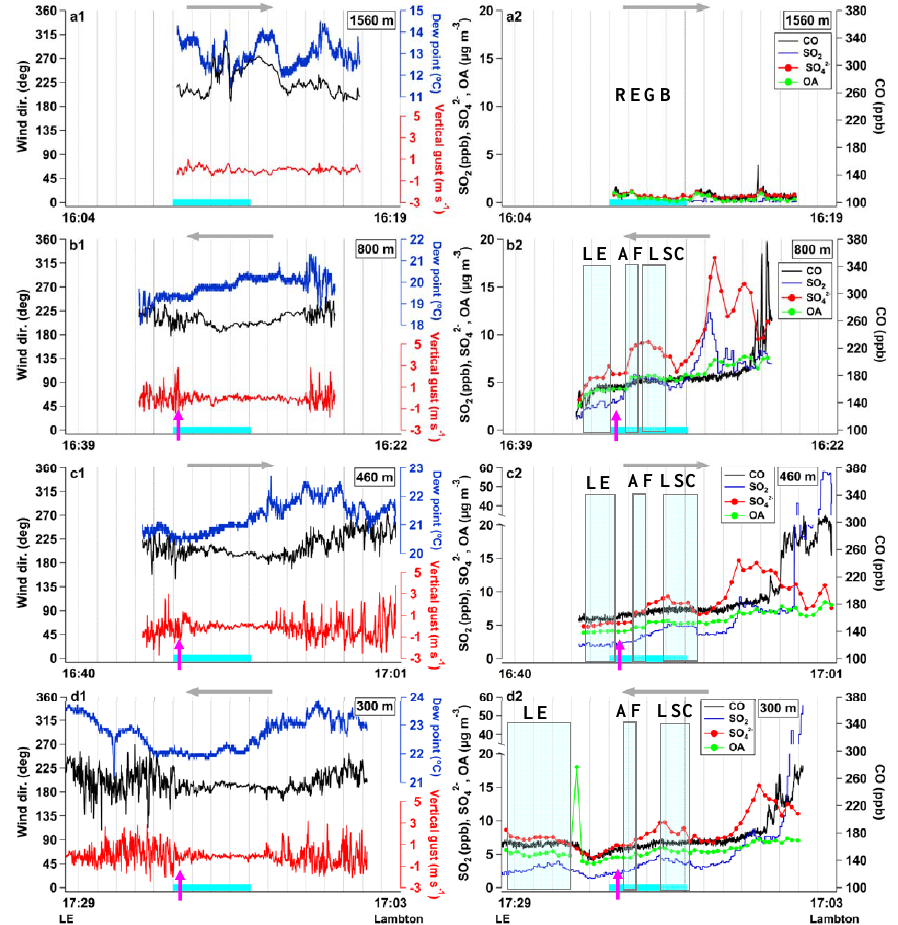
Fig. 4. Flight 5 wind direction, dewpoint, vertical gust velocity, SO 2 , SO 2 − , OA, and CO measured from the aircraft along tracks at (a) 4 1560ma.g.l., (b) 800ma.g.l., (c) 460ma.g.l., and (d) 300ma.g.l. over LSC. Blue bar along horizontal axis=LSC; coloured arrow indicate lake breeze front (magenta=LE/LSC merged front). Horizontal axis is fixed to geographical length of the longest transect; start/end times refer to data. Data are plotted as in Fig. 3. Light blue boxes are selected time slices discussed in Sect.